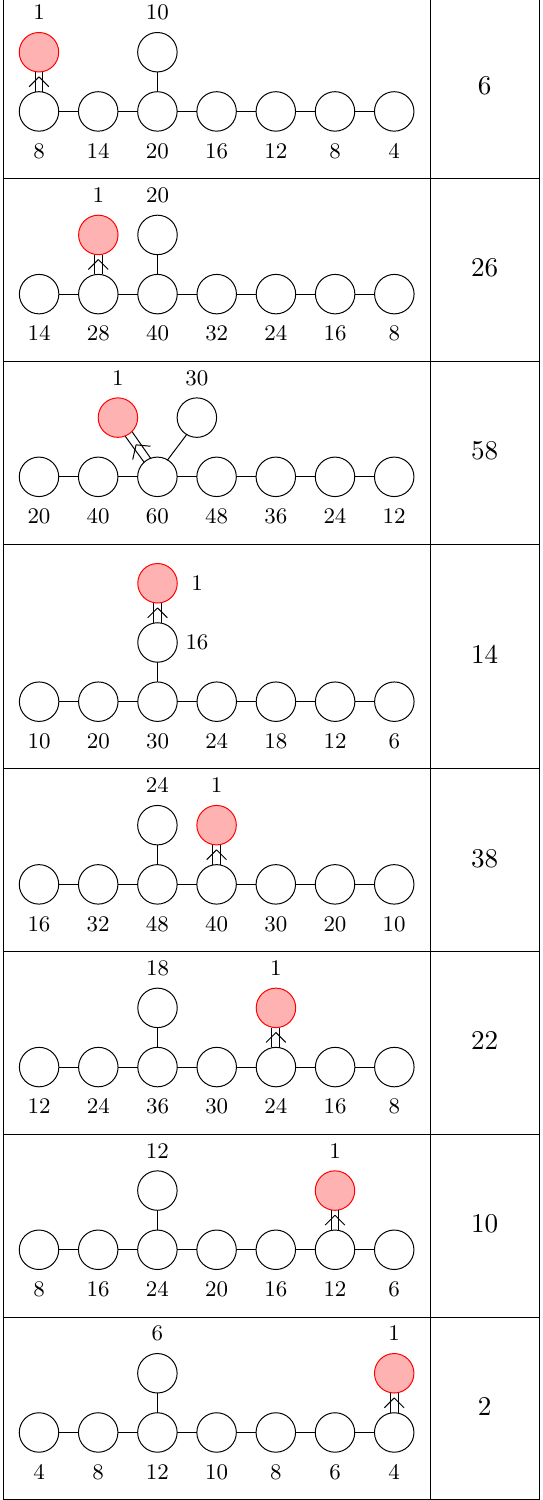
Table 25 . Exotic minimally unbalanced quivers of E 8 -type with inward double laced